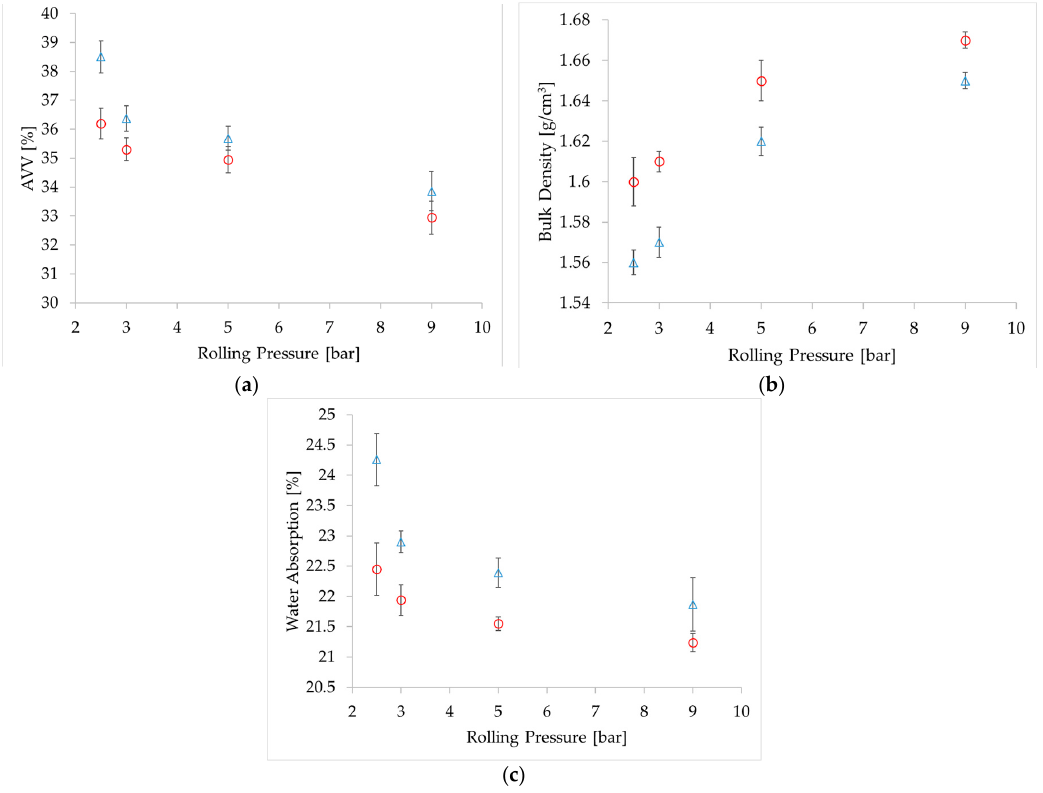
Figure 9. Average values of physical properties of non-carbonated and carbonation curing with di ff erent rolling pressure ( ∆ NCC, ● 5 h ACC): ( a ) Apparent void volume (AVV); ( b ) bulk density (BD) and ( c ) water absorption (WA).